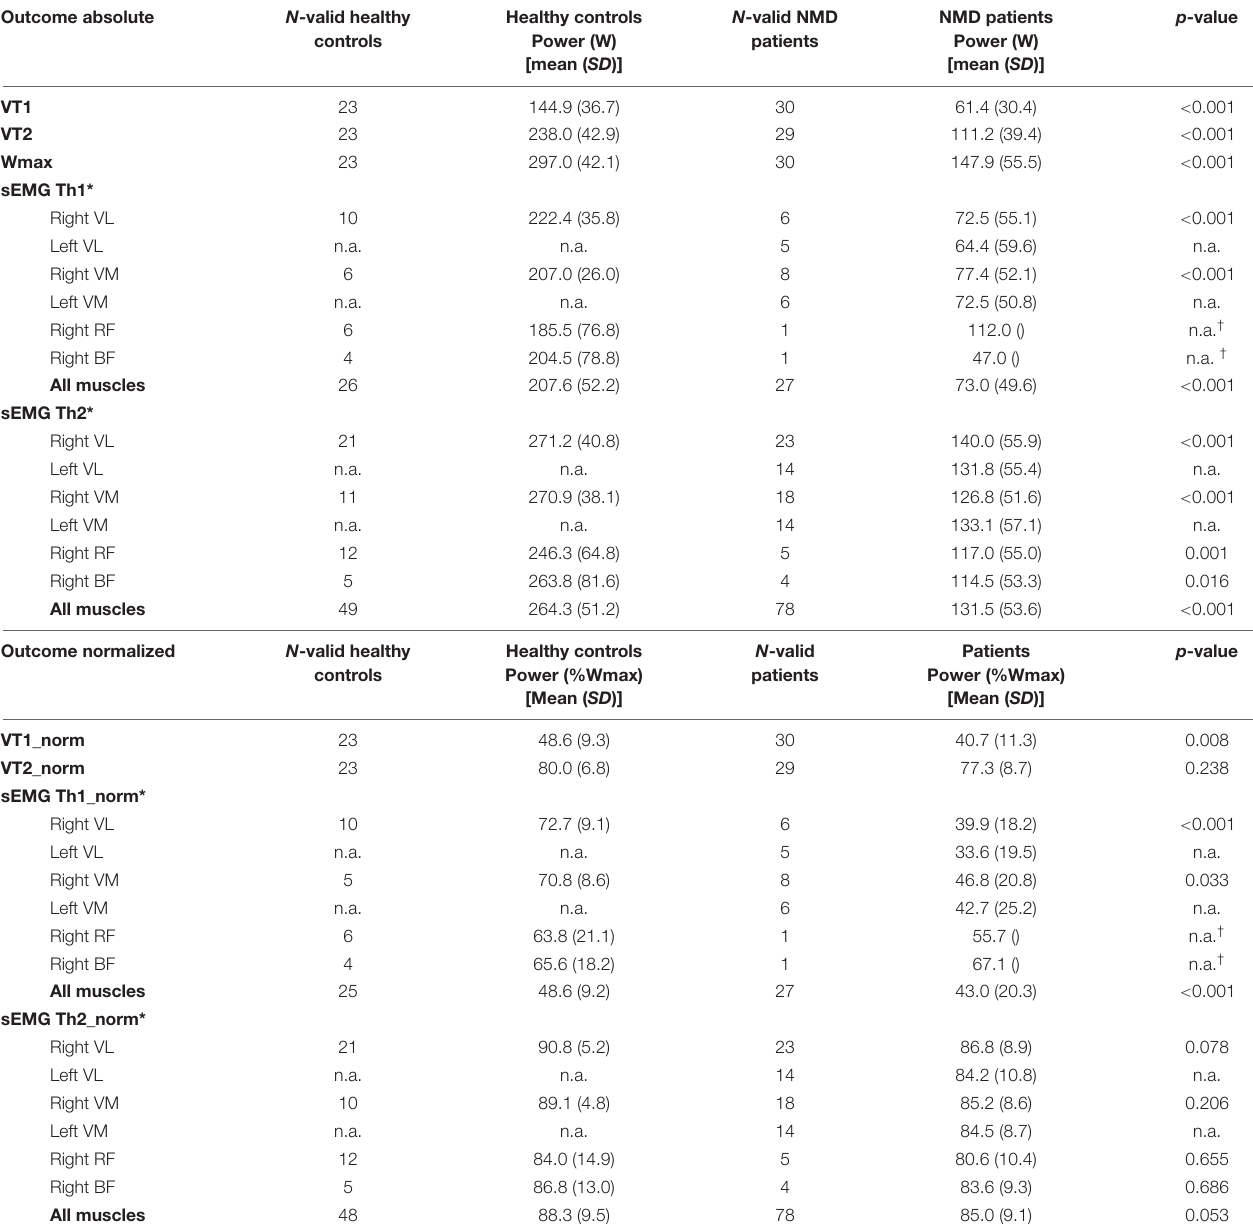
TABLE 6 | Construct